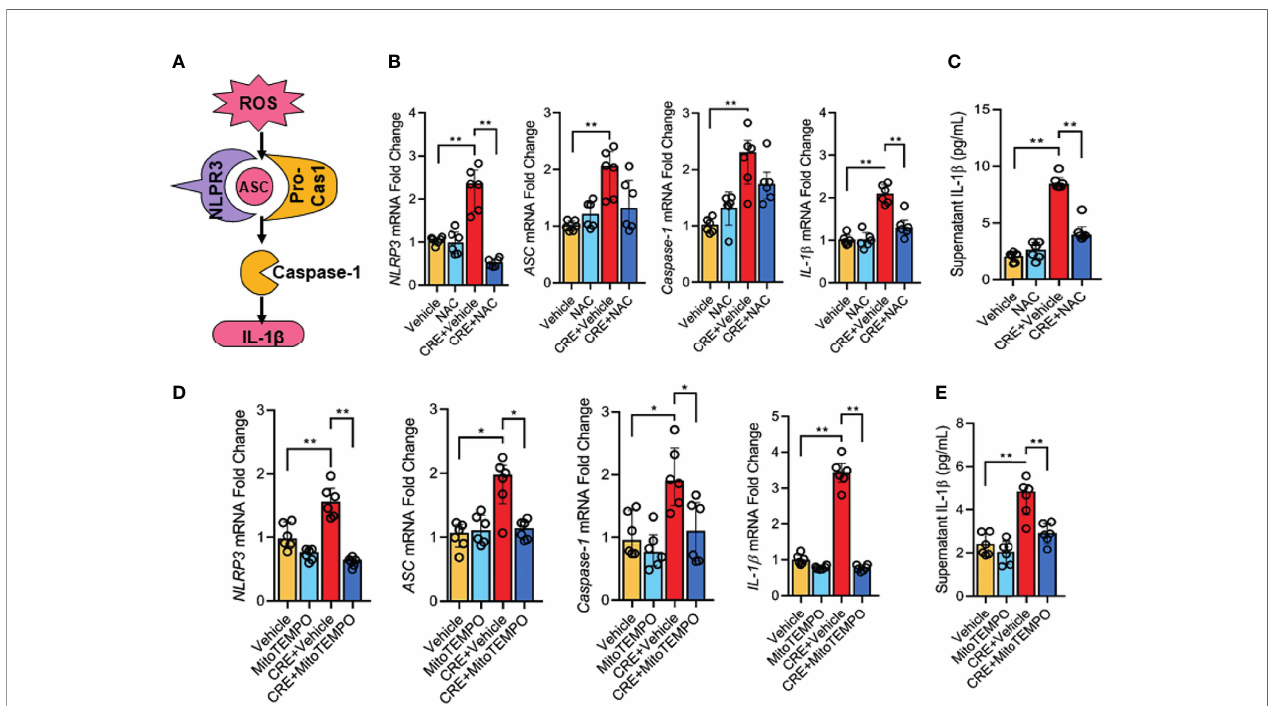
FIGURE 6 | ROS is required in cockroach allergen-induced NLRP3 in fl ammasome activation. (A) Scheme for ROS-induced NLRP3 in fl ammasome activation. (B) Expression of NLRP3 in fl ammasome components) in CRE-treated HBECs in the presence or absence of NAC as detected by RT-PCR (n = 6). (C) Levels of IL- 1 b in supernatant of CRE-treated HBECs in the presence or absence of NAC (n = 6). (D) Expression of NLRP3 in fl ammasome activation components in CRE-treated mice in the presence or absence of Mito TEMPO as detected by RT-PCR (n = 6). (E) Levels of IL-1 b in supernatant of CRE-treated HBECs in the presence or absence of Mito TEMPO (n=6). Data represent as medians with interquartile (IQR). * P < 0.05, ** P <